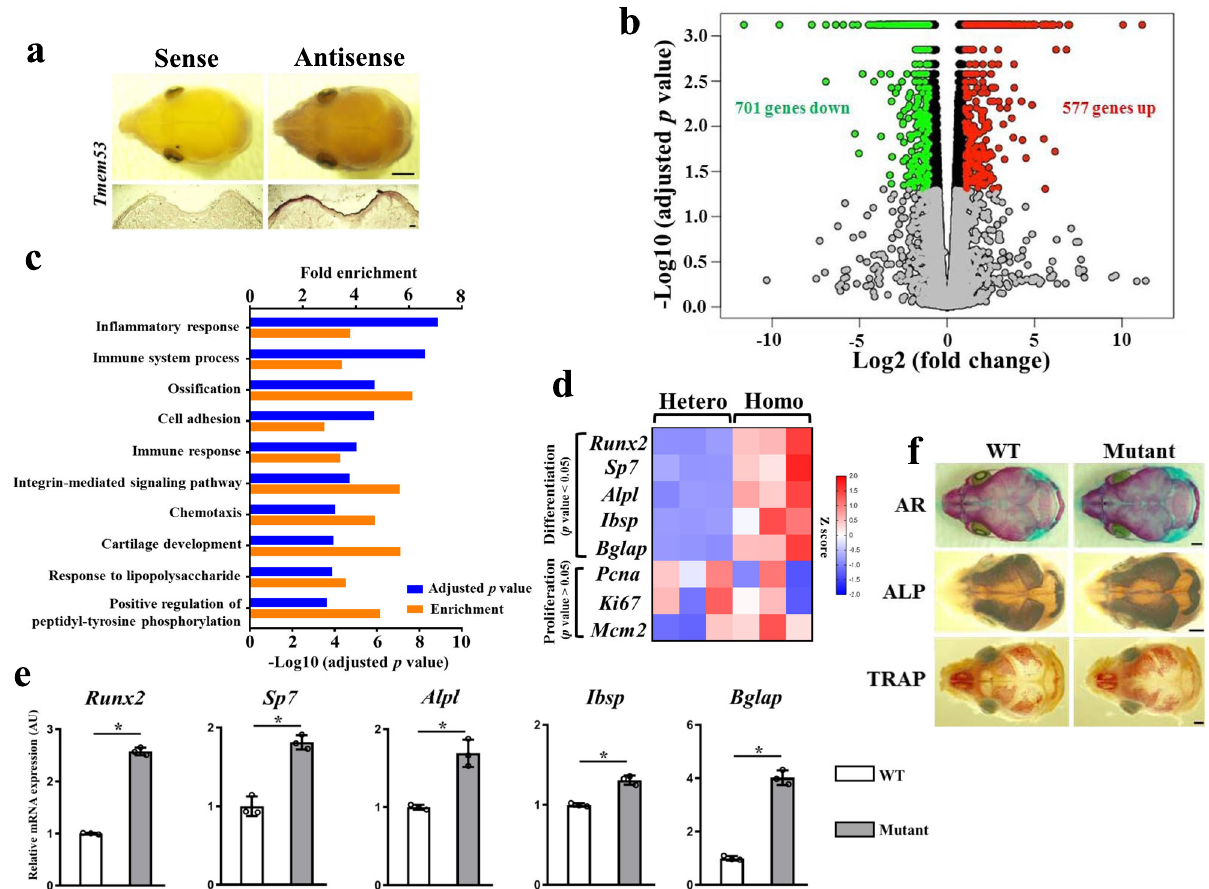
Fig. 4 Enhanced differentiation of calvaria osteoblast in Tmem53 mutant mice. a In situ hybridization (ISH) for Tmem53 . The upper panels show dorsal views of cephalic whole-mount ISH at E16.5, scale bar, 1 mm; the lower panels show coronal ISH sections of the calvaria at P1, scale bar, 100 μ m ( n = 3 mice). b Volcano plot of RNA-seq data for calvaria showing differentially expressed genes (DEGs) in Tmem53 mutant mice (Homo) versus their heterozygous littermates (Hetero) ( n = 3 animals for each group) with respect to fold change (FC) and signi fi cance (adjusted P value). Each dot represents an individual gene. Gray dots represent genes with no signi fi cantly differentially expressed ( P > 0.05). Green dots represent signi fi cant downregulated DEGs (FC < 0.5) and red dots represent signi fi cant upregulated DEGs (FC > 2). Statistical signi fi cance was assessed using two-sided t -test. P value is adjusted by false discovery rate (FDR). c Gene ontology (GO) enrichment analysis for the DEGs by DAVID 6.8 showing top 10 signi fi cantly enriched GO terms for the DEGs in biological processes. Statistical signi fi cance was assessed using one-sided Fisher ’ s exact probability test. P value is adjusted by FDR. d Heat map of representative DEGs associated with osteoblast differentiation and representative genes associated with cell proliferation. e RT – qPCR-based validation of the DEGs found via RNA-seq to be upregulated in the calvaria of Tmem53 mutant mice. WT, wild type. Data are mean ± SD ( n = 3 biologically independent samples). * P = 0.000003, 0.0008, 0.0025, 0.0008, and 0.00005 for Runx2 , Sp7 , Alpl , Ibsp , and Bglap , respectively. Statistical signi fi cance was assessed using two-sided t -test. f Dorsal views of the skull stained by Alizarin Red (AR) at P2, alkaline phosphatase staining (ALP) at E16.5, and tartrate-resistant acid phosphatase (TRAP) at P4, respectively ( n = 3 animals for each group). Scale bar, 1 mm. Source data are provided as a Source Data fi